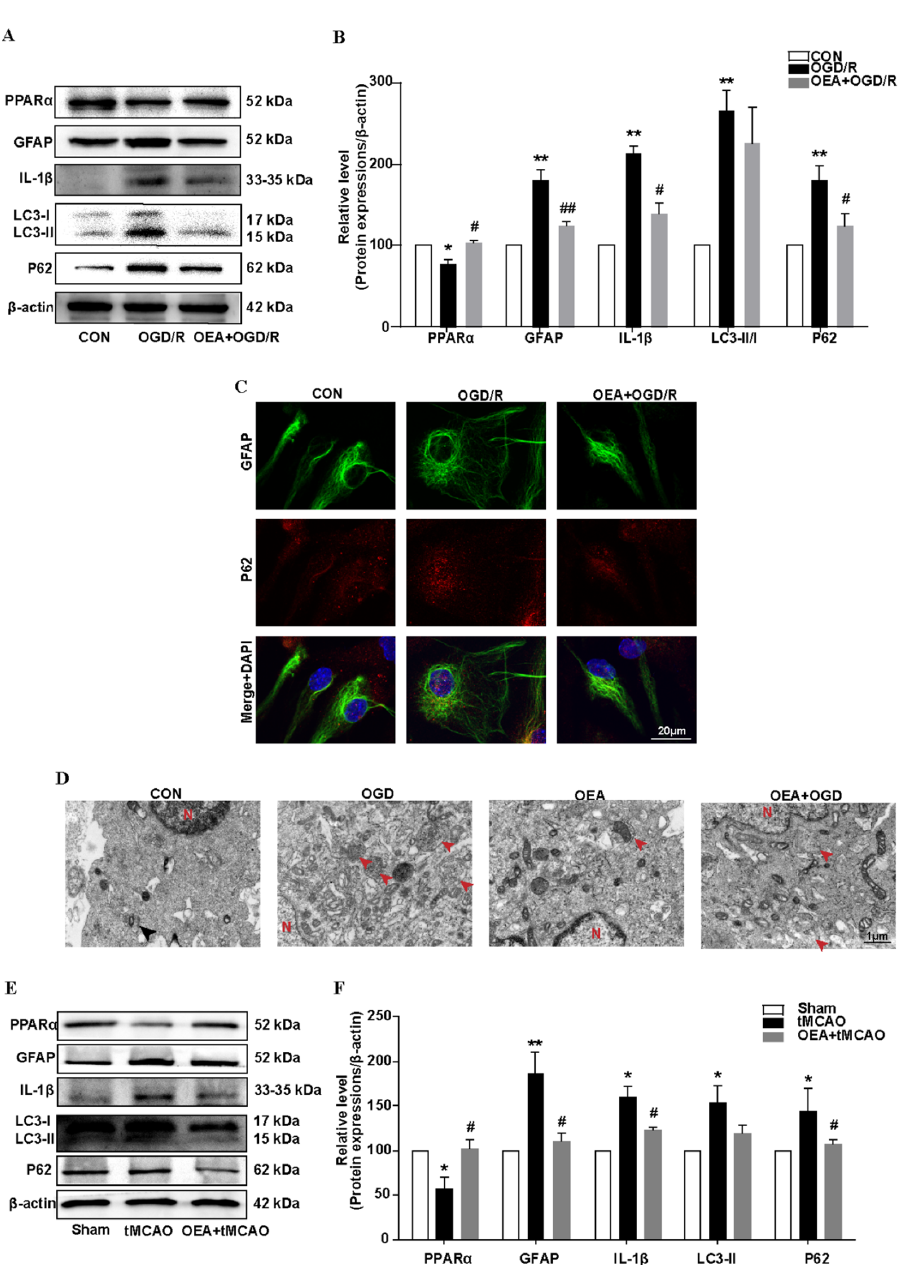
Figure 4. PPAR α agonist OEA restores the autophagic fl ux and inhibits astrocyte activation after brain ischemia in vitro and in vivo. ( A , B ) The immunoblo tt ing analysis and quanti fi cation of PPAR α , GFAP, IL-1 β , LC3-II/I, and p62 in vehicle- or OEA-treated astrocytes after exposure to OGD/R. OEA